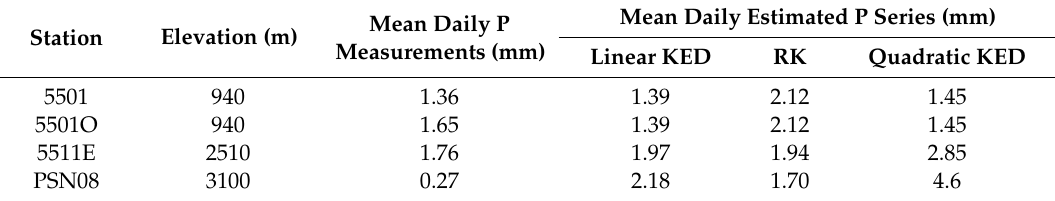
Figure 12. Corrected mean daily precipitation depending on elevation in Canales basin (corrected fields vs. original data). Table 6. Mean daily precipitation in the stations located in the case